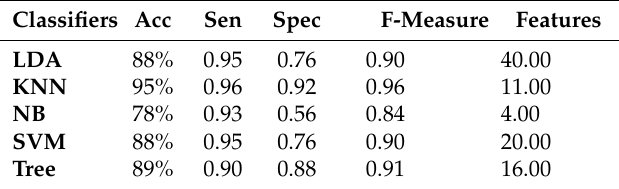
Table 7. Classification results after feature selection by SFS.